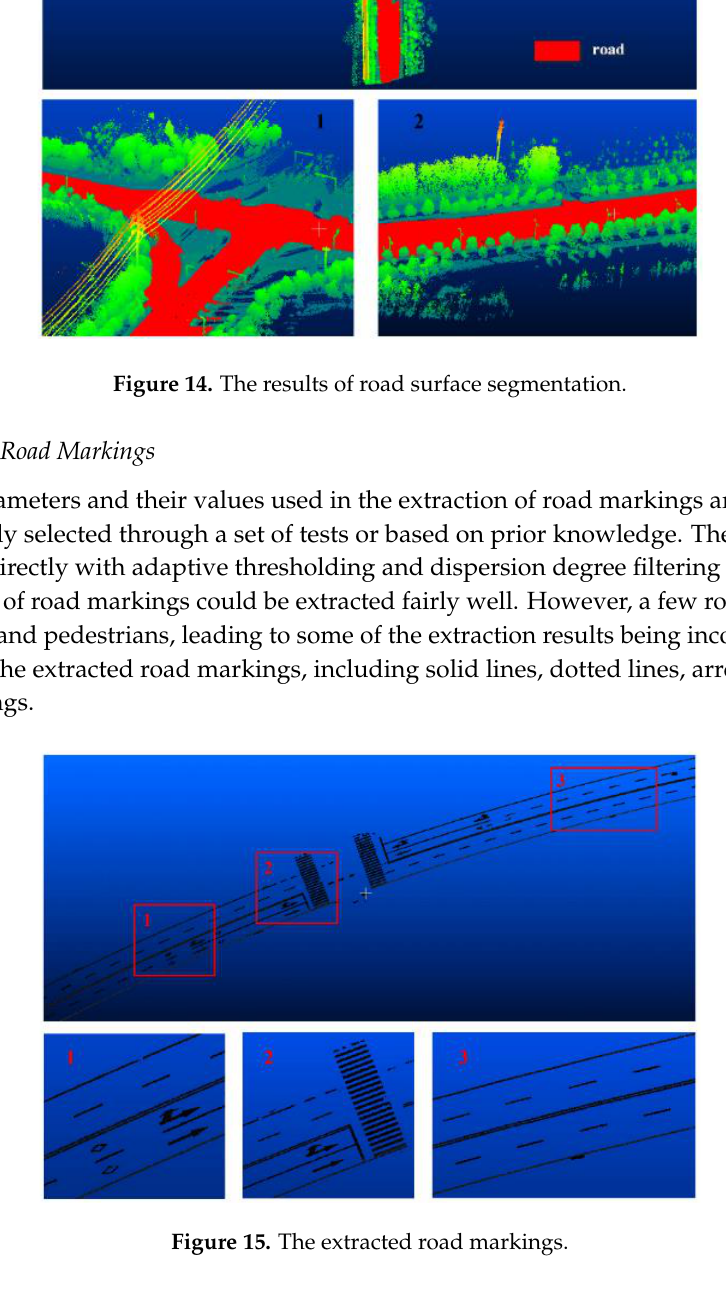
Figure 15. The extracted road markings.